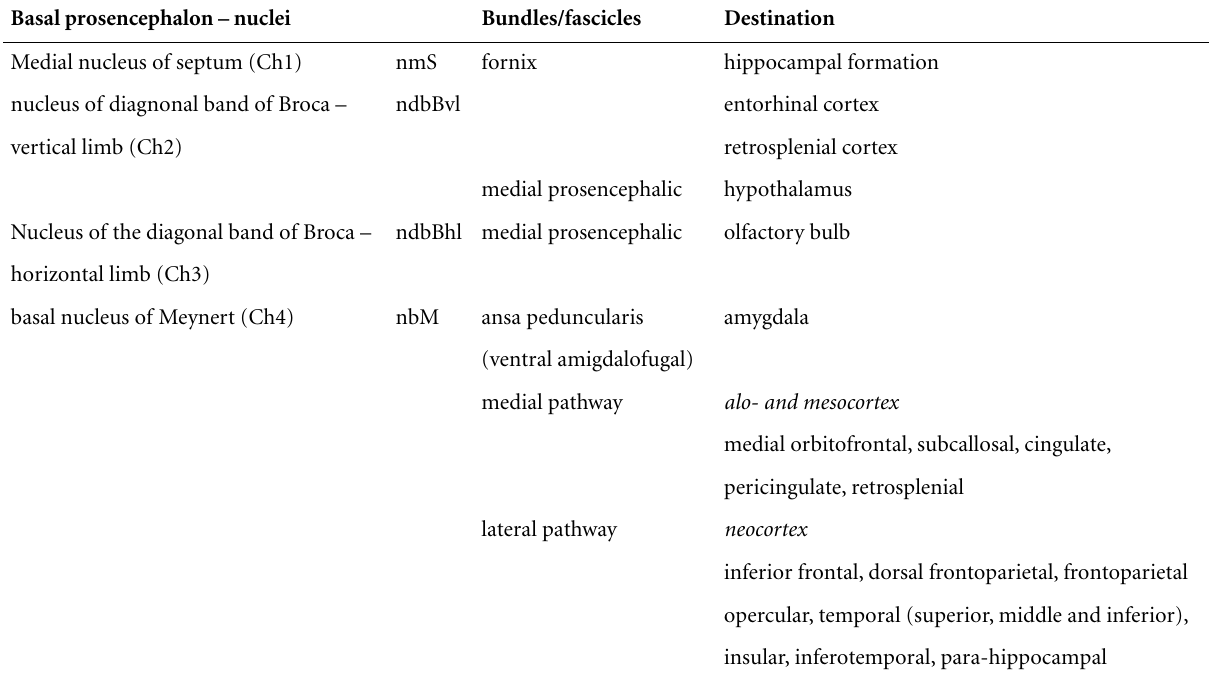
Table 1. Brain cholinergic system – cholinergic groups, main projections and most important destinations of the basal prosen- cephalon.